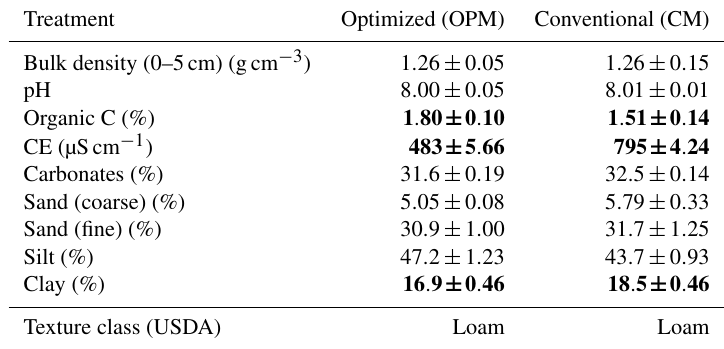
Table 1. Physical-chemical properties of the soil (0–30cm) in OPM and CM treatments and the textural characterization of both treatments. Mean ± standard deviation of the mean ( n = 3). Statistically significant differences ( p < 0 . 05) are in